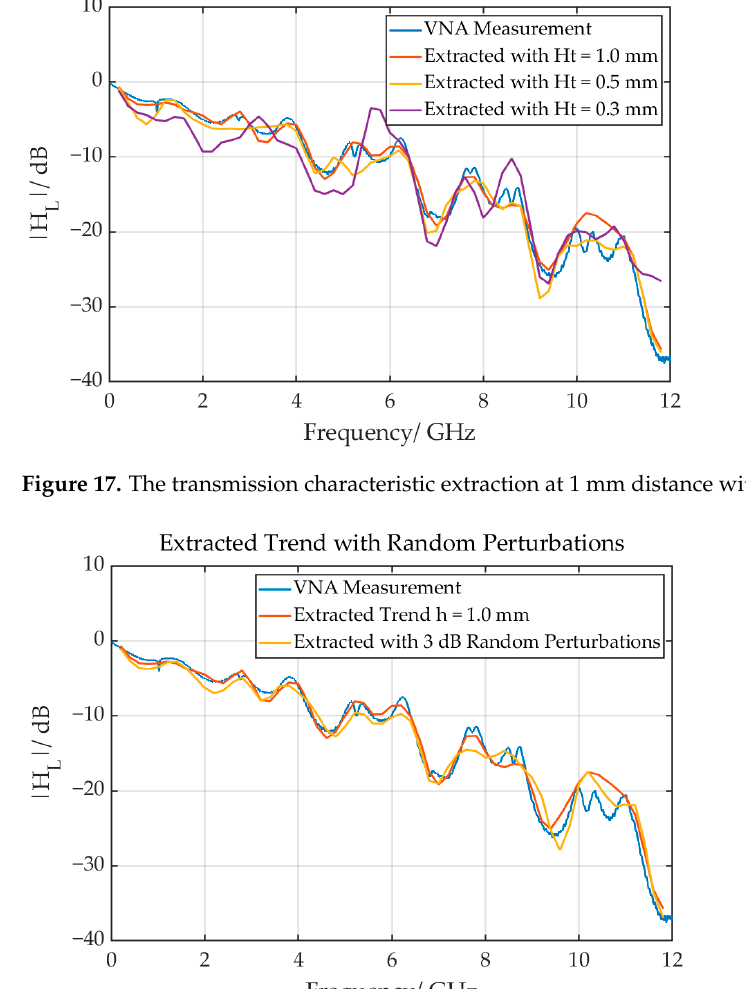
Figure 18. The transmission characteristic extraction at 1 mm distance with random perturbations.